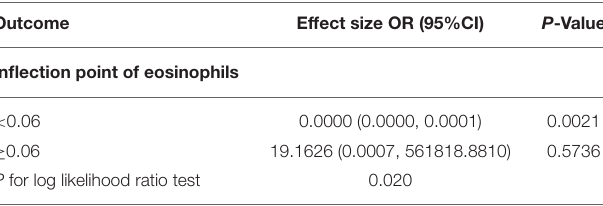
TABLE 3 | The results of the two-piecewise linear regression